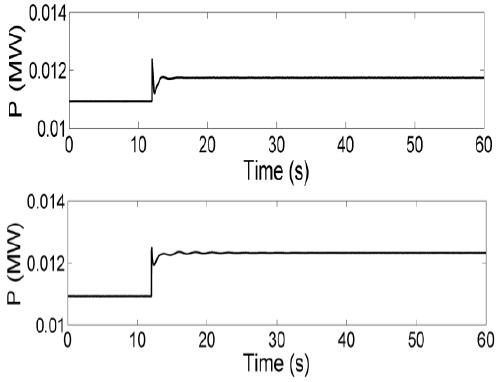
Figure 18. Diesel´s active power output with & without the battery inverter (load